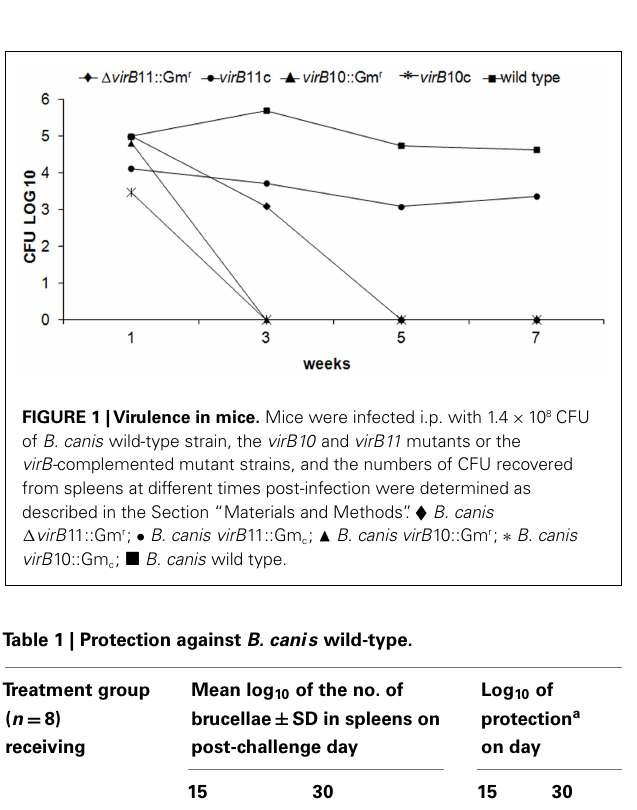
rized in Table 1 . The virB 10::Gm inoculation generated